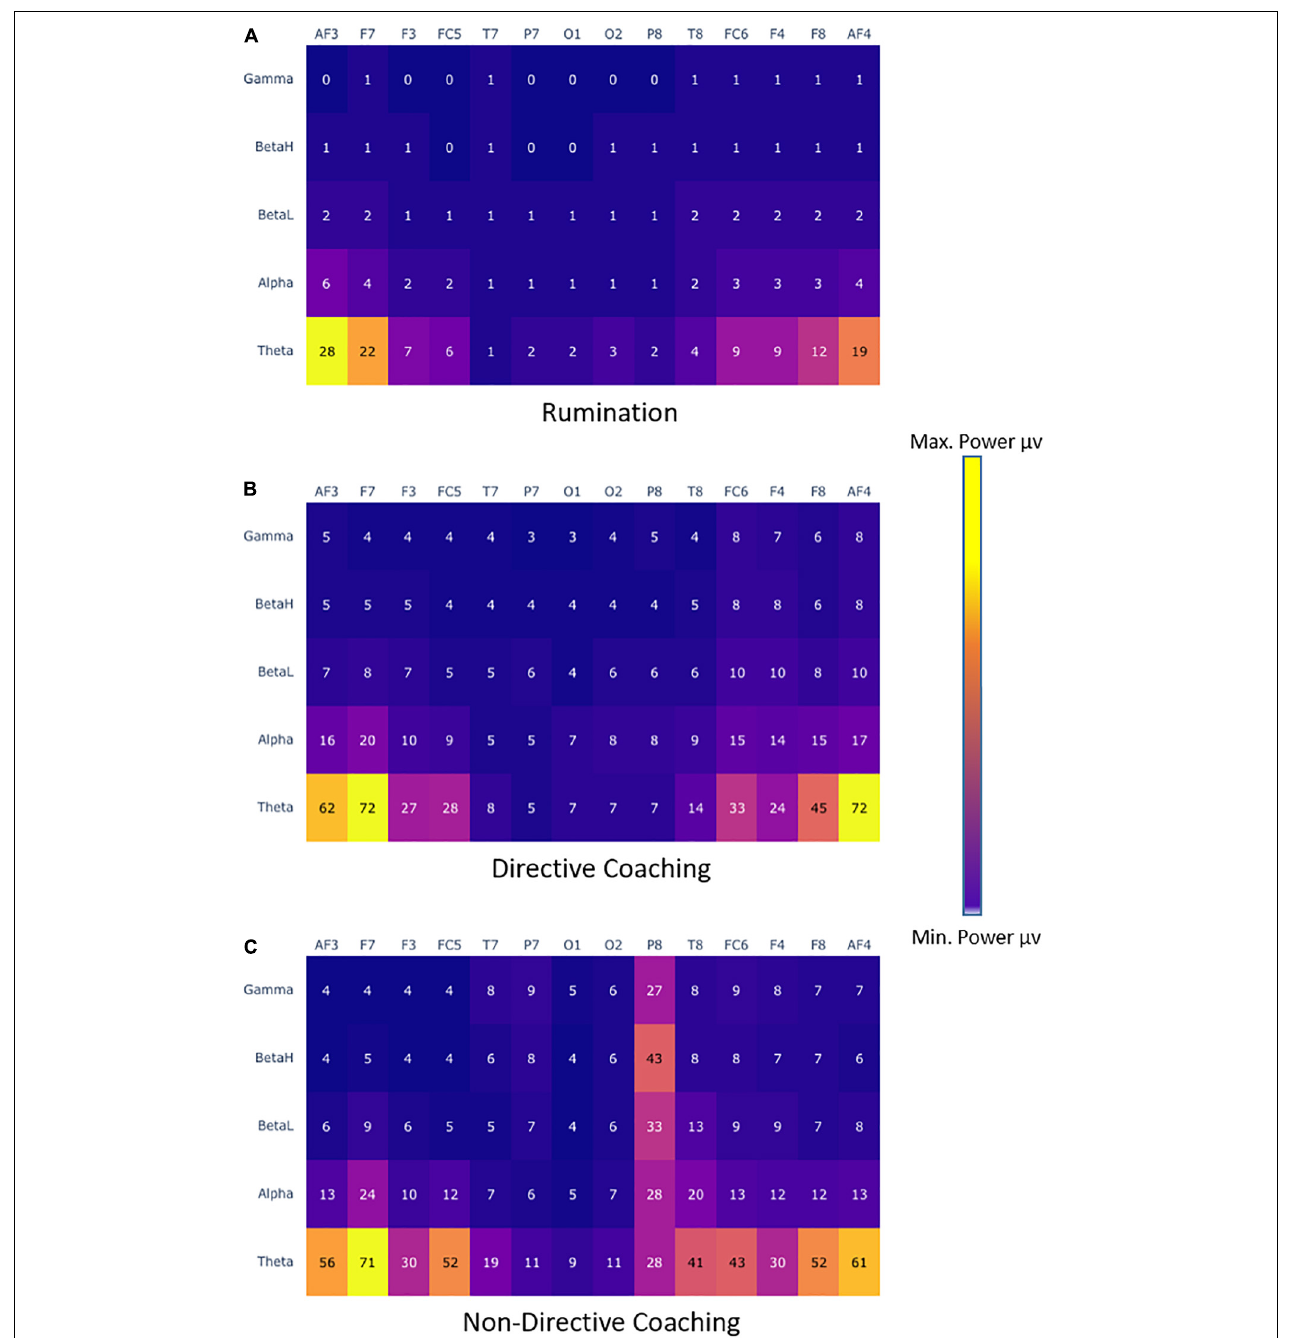
FIGURE 3 | Heat map of EEG power generated by insights in each experimental condition [ (A) Rumination, (B) Directive coaching, and (C) Non-directive coaching]. Heat maps indicates the magnitude of the effect of EEG power at each frequency band (gamma, beta low and high, alpha, and theta) across 14-EEG channels (AF3, F7, F3, FC5, T7, P7, O1, O2, P8, T8, FC6, F4, F8, and AF4). Colors represent values resulting from the median of the power ( µ v) for epochs of 4 s prior to the marker activated (press space bar) by the subjects during each condition. Cold colors indicate decrease, whereas hot colors indicate increase in the median of the EEG power for each cortical region (electrode sites) and frequency wave